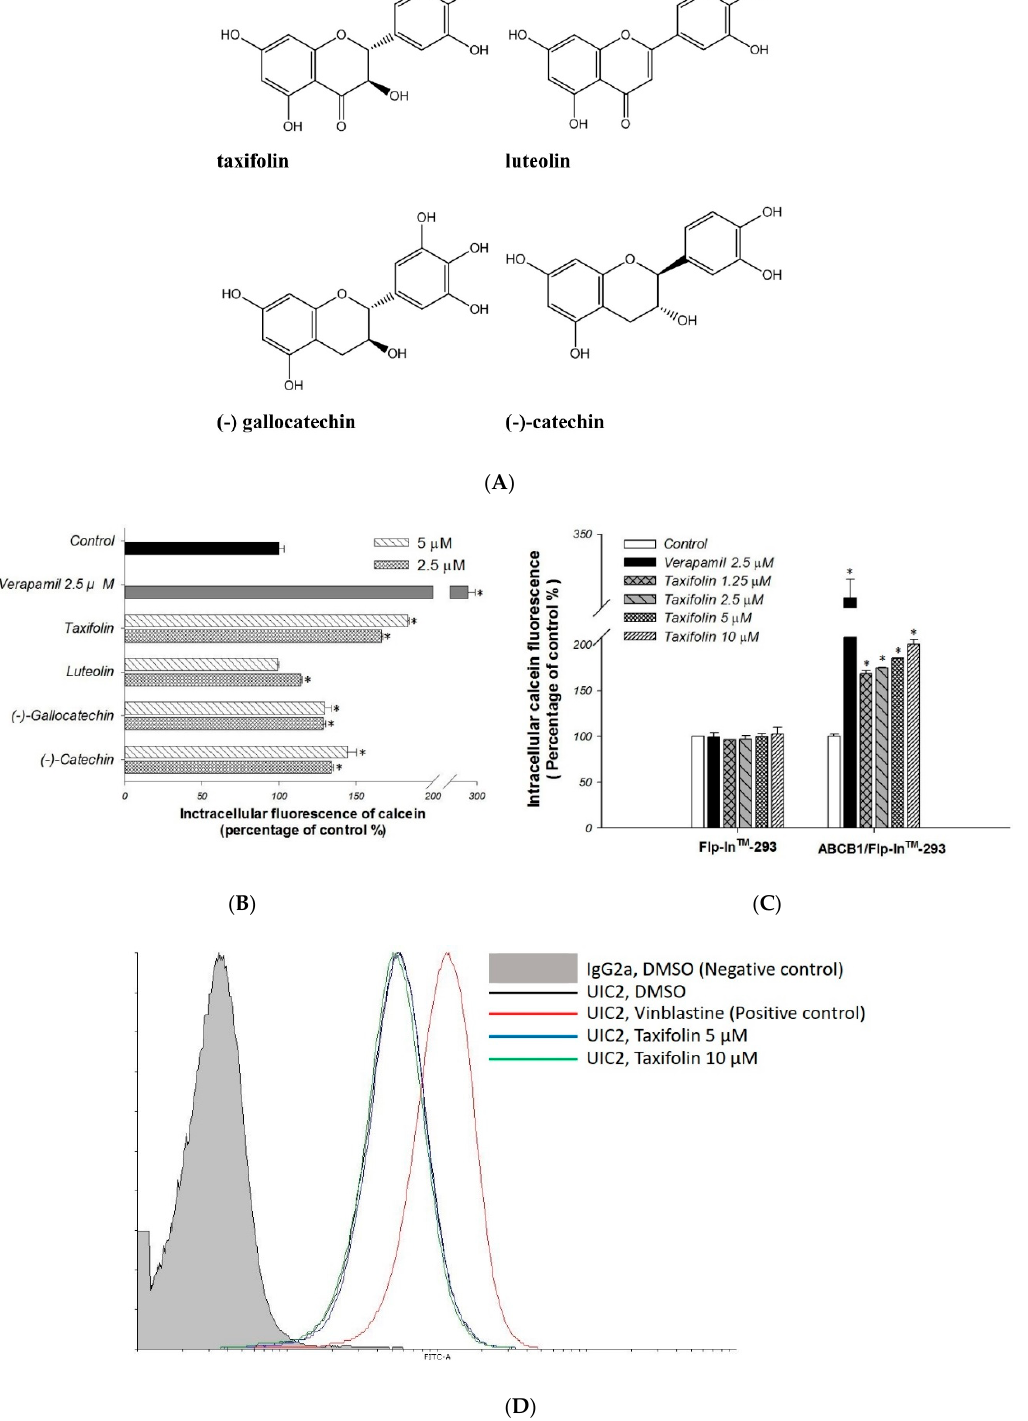
Figure 1. Evaluation of the effects of taxifolin, luteolin, ( − )-gallocatechin, and ( − )-catechin on P-gp transporter activity. ( A ) Chemical structures of taxifolin, luteolin, ( − )-gallocatechin, and ( − )-catechin. ( B , C ) The intracellular calcein fluorescence was significantly increased by taxifolin treatment in a dose dependent manner in ABCB1 /Flp-In TM -293 cells. Verapamil 2.5 µ M was used as a positive control. * denotes p < 0.05 as compared to untreated control. ( D ) In MDR1 shift assay, the UIC2 fluorescence intensity showed no difference between taxifolin treatment and solvent control as compare to the positive control vinblastine. Data presented as mean ± SE of at least three experiments, each in